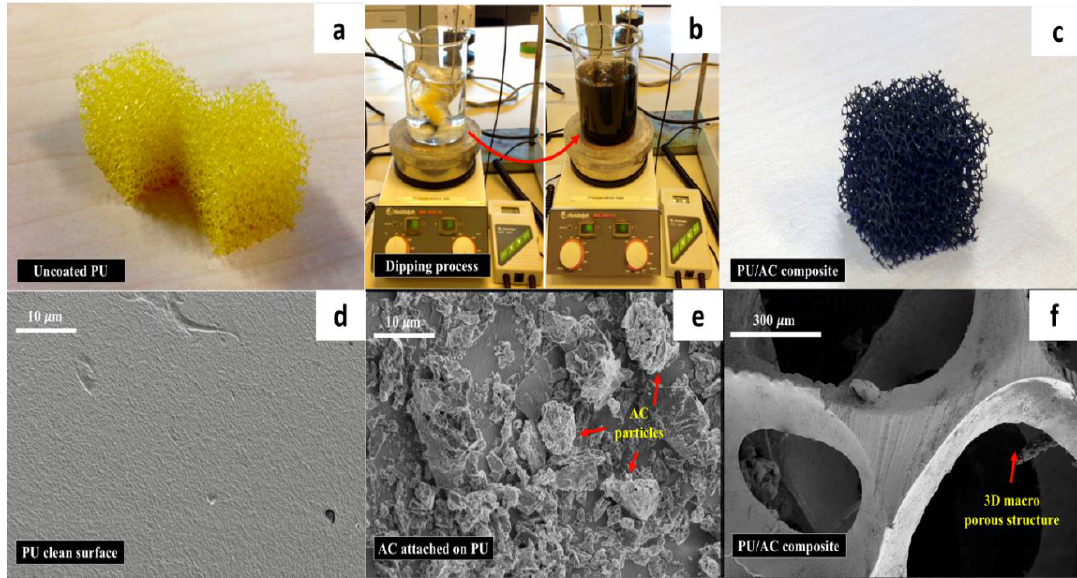
Figure 4. ( a ) Uncoated clean polyurethane cube (1.5 × 1.5 × 1.5 cm); ( b ) water-based process to